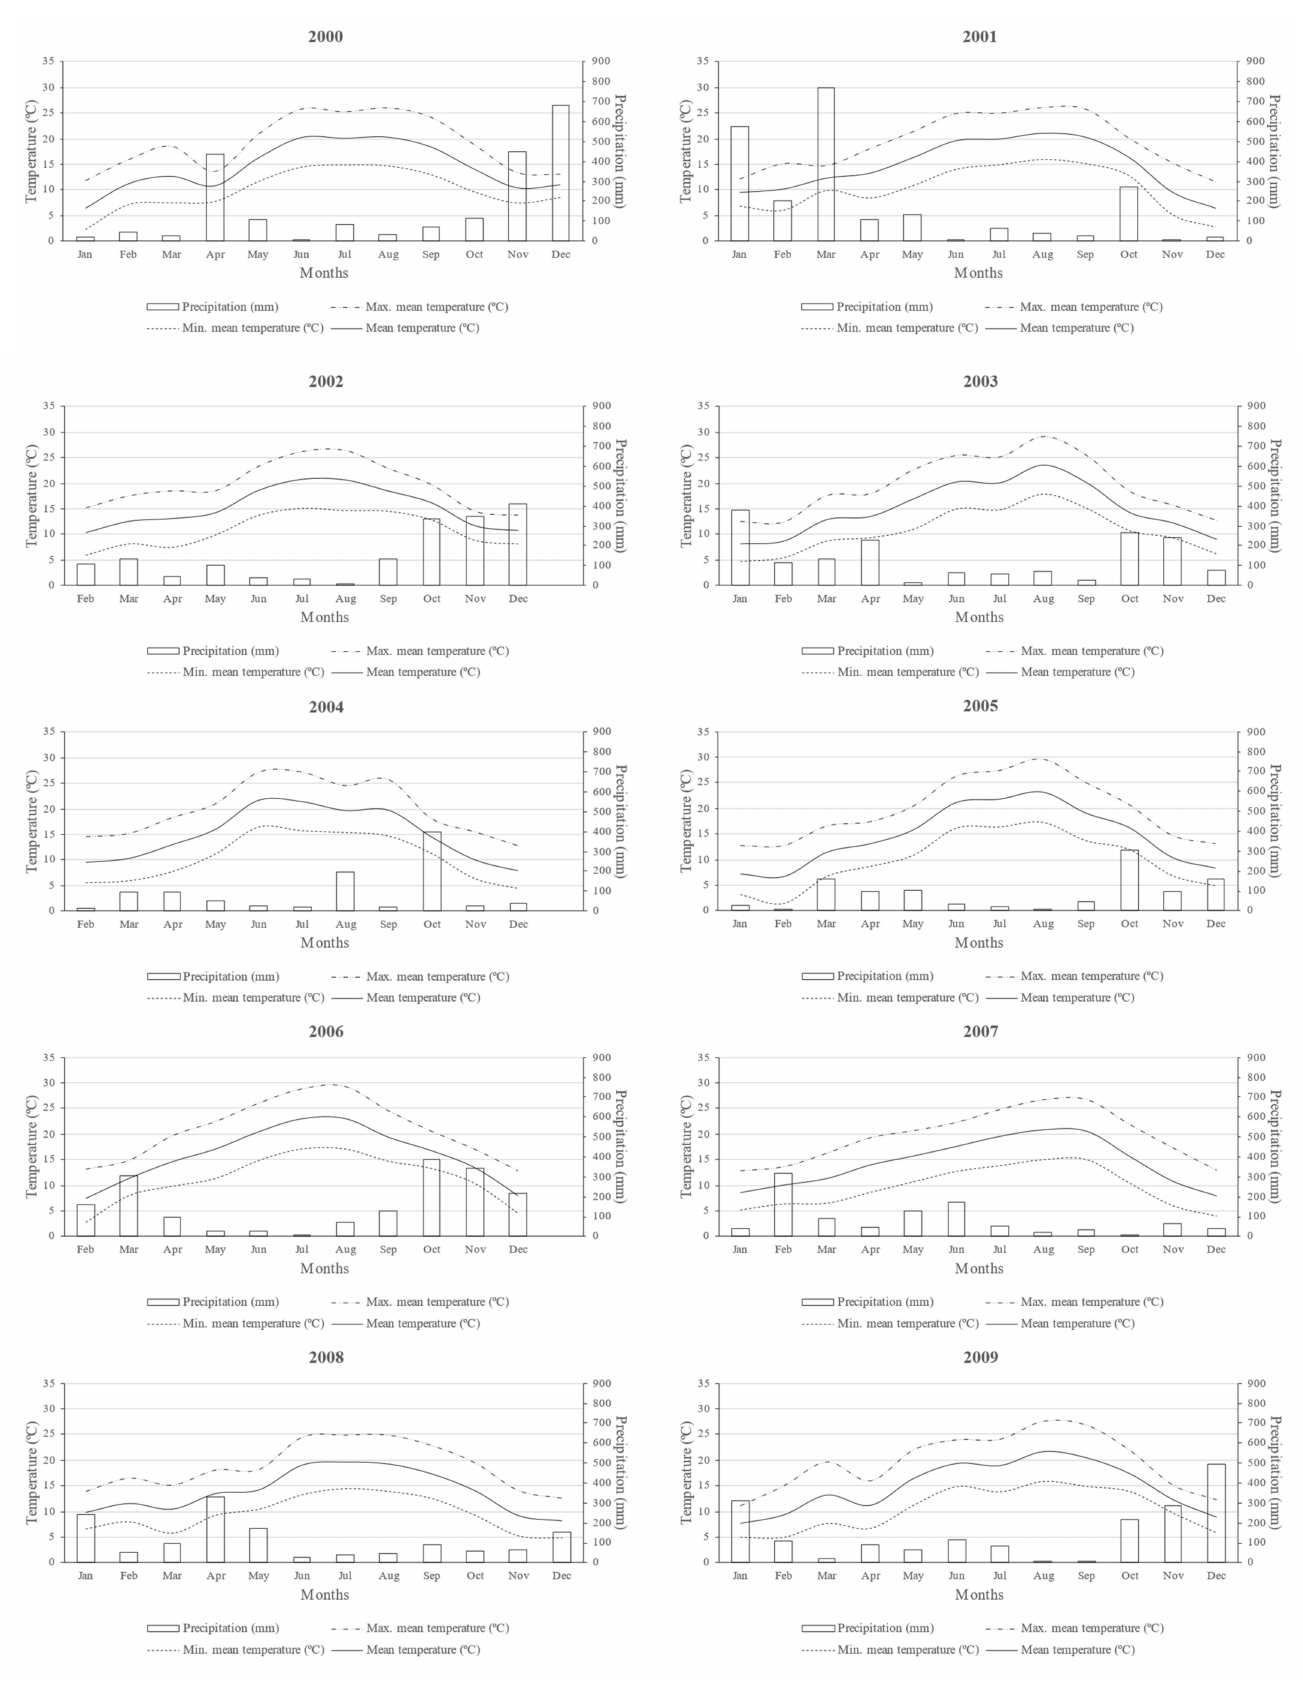
Figure 5. Distribution of climatic parameters for the decade of